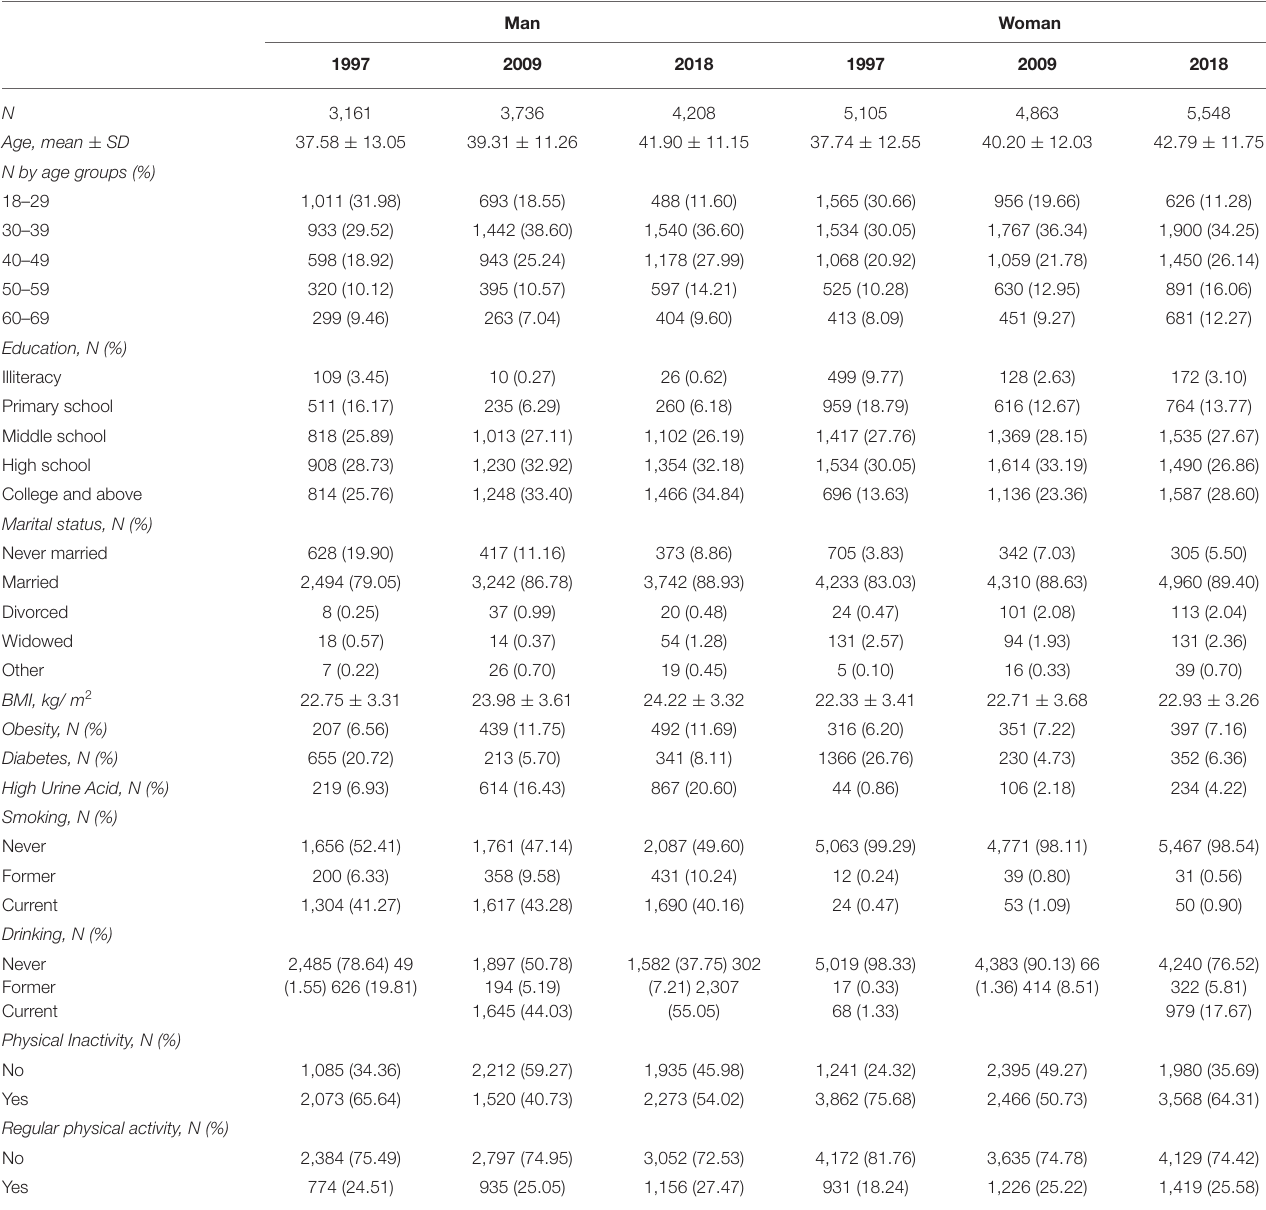
TABLE 1 | Characteristics of the study